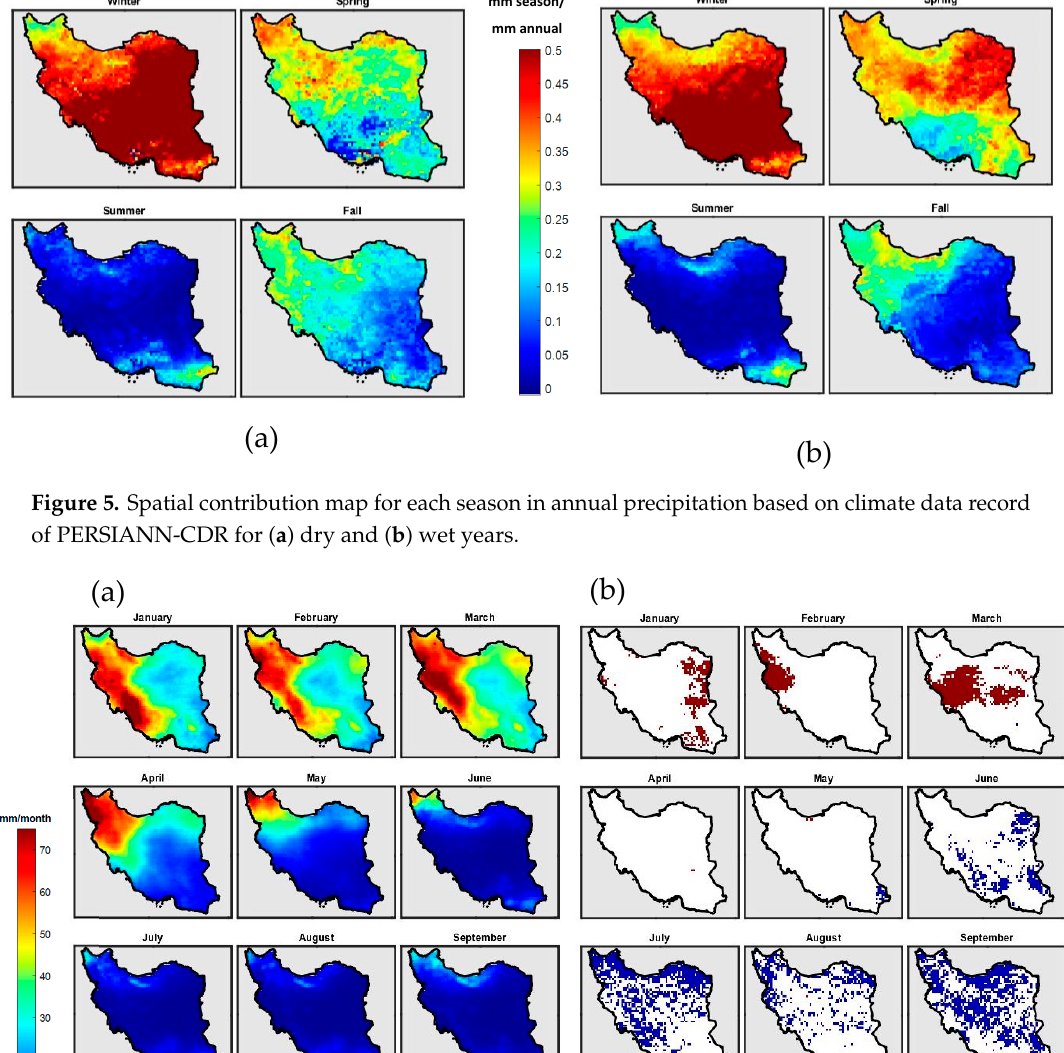
Figure 7. ( a ) Average percentage of each month contribution in annual precipitation; ( b ) monthly contribution trend analysis, blue and red part present the positive and negative trend, respectively.